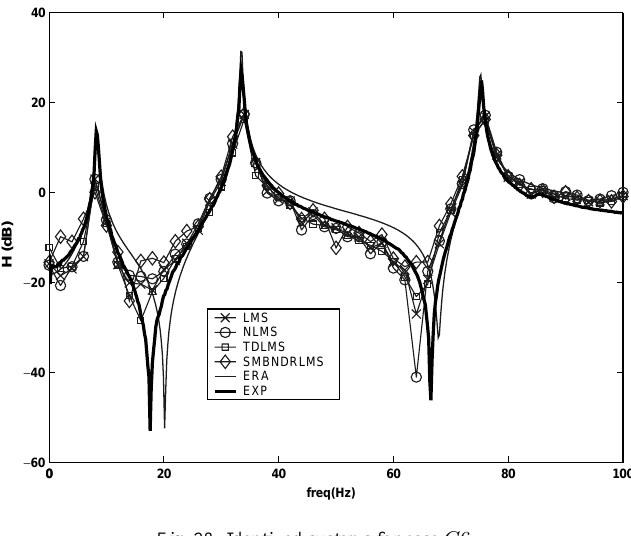
Fig. 28. Identified systems for case C 6